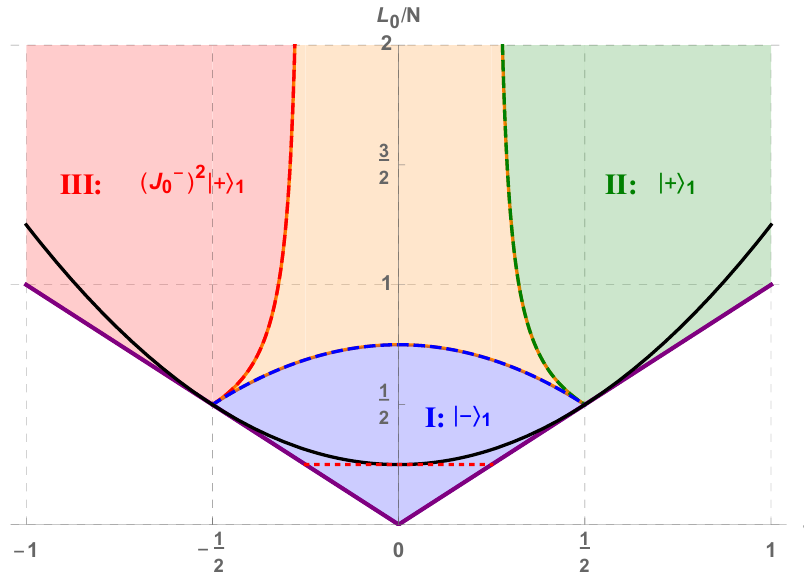
Figure 10 . The phase diagram on the J - L 0 plane in the NS sector. See the caption of (cid:12)gure 6 for explanation of regions and curves. Because of the (cid:13)ip involved in the map (2.9), the positions of regions II and III are switched relative to the R sector (see (cid:12)gure